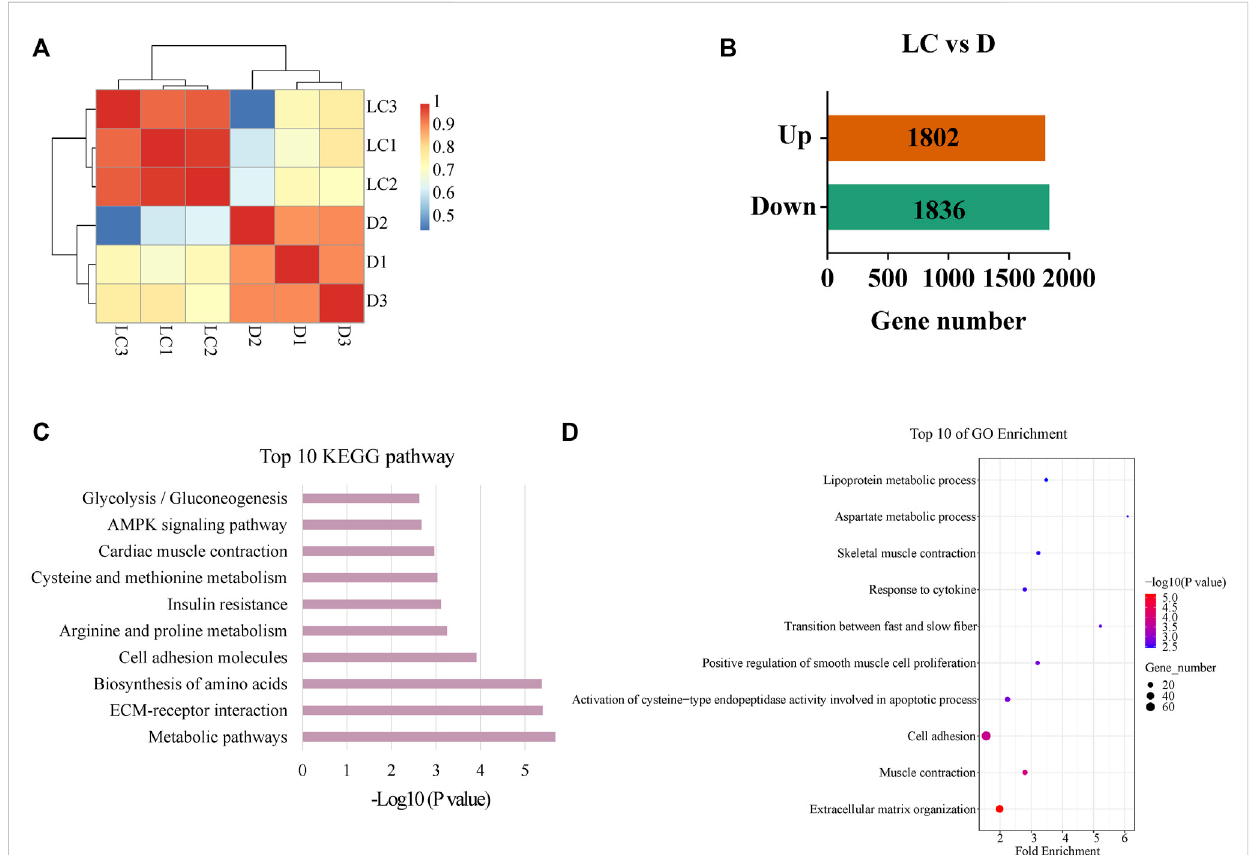
FIGURE 3 Analysis of DEGs between Luchuan and Duroc. (A) Correlation of gene expression of DEGs based on TPM. (B) Number of upregulated and downregulated DEGs. (C) Top 10 most enriched pathways of the DEGs based on p -value. (D) Top 10 GO enrichment terms based on p -value; the size of dots indicates number of genes related to the